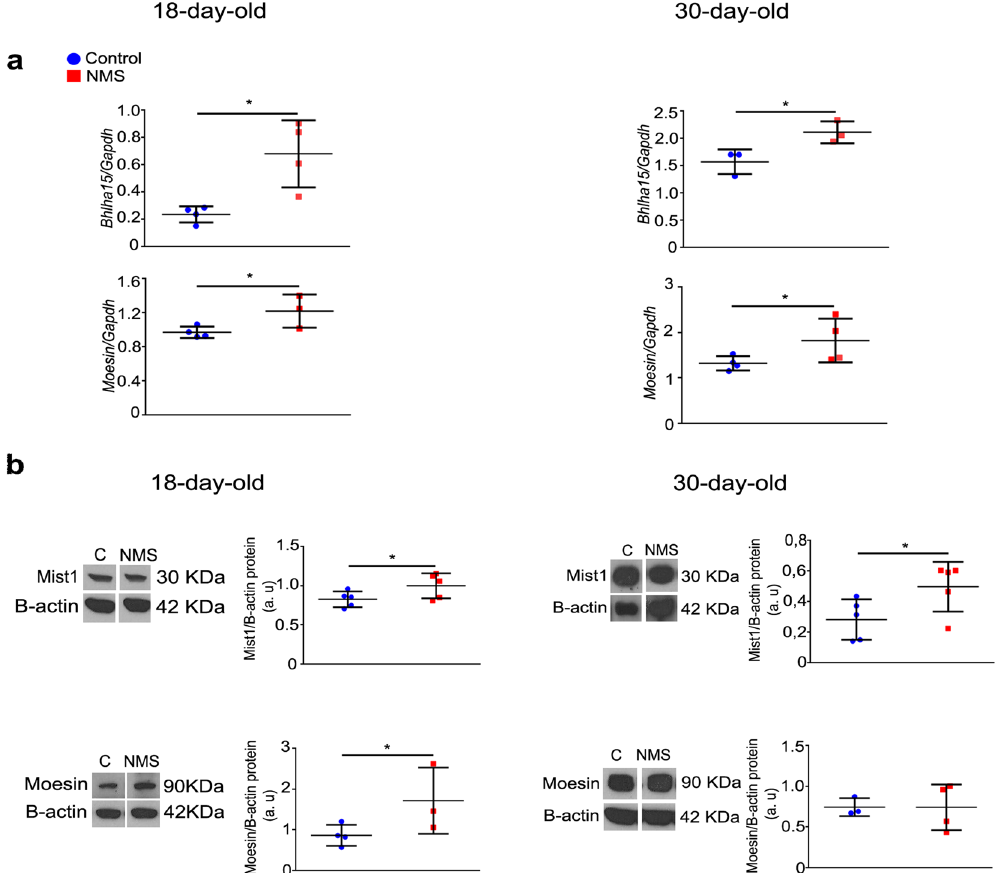
Figure 5. NMS effects on Mist1 and moesin at gene expression and protein levels in the gastric mucosa at 18 and 30 days. ( a ) Expression of Bhlha15 and moesin genes as evaluated by RT-qPCR and shown as fold change of Gapdh . ( b ) After immunoblot, bands for Mist1 and moesin were cropped to represent control and NMS groups (whole blot in Supplementary Fig. 4). Protein levels were determined after comparison to the loading control with Beta- actin. Values are individually represented as well as means ± SD for control (blue) and NMS (red) groups. * P < 0.05 as compared to control groups by Student t